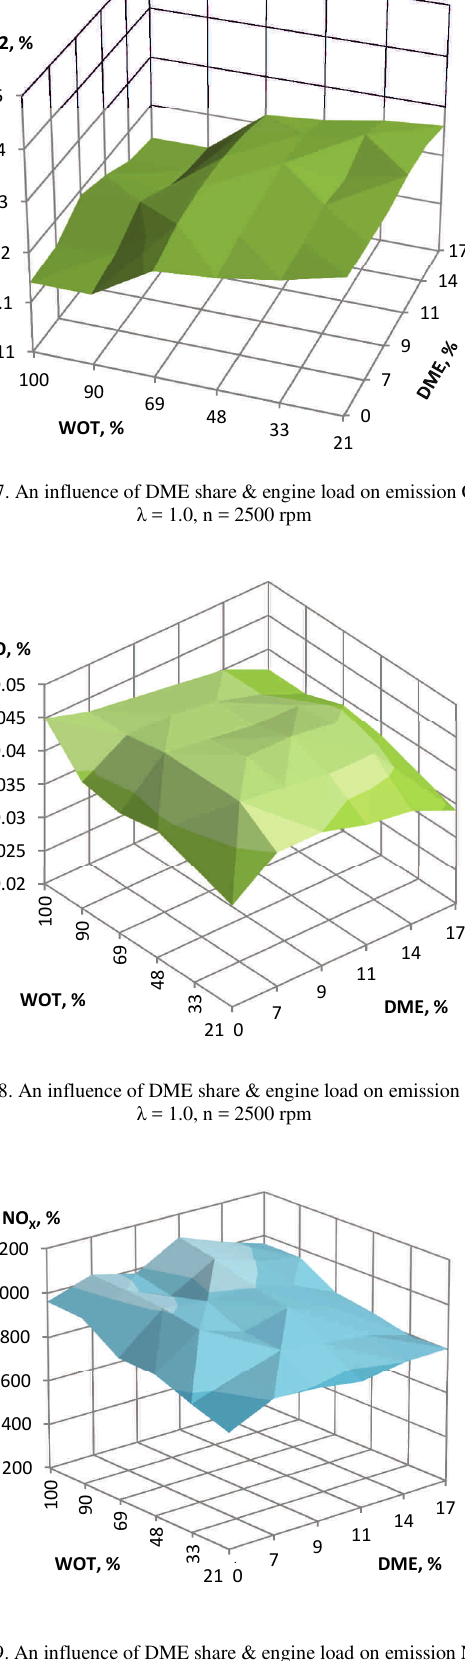
Fig. 19. An influence of DME share & engine load on emission NO x , λ = 1.0, n = 2500